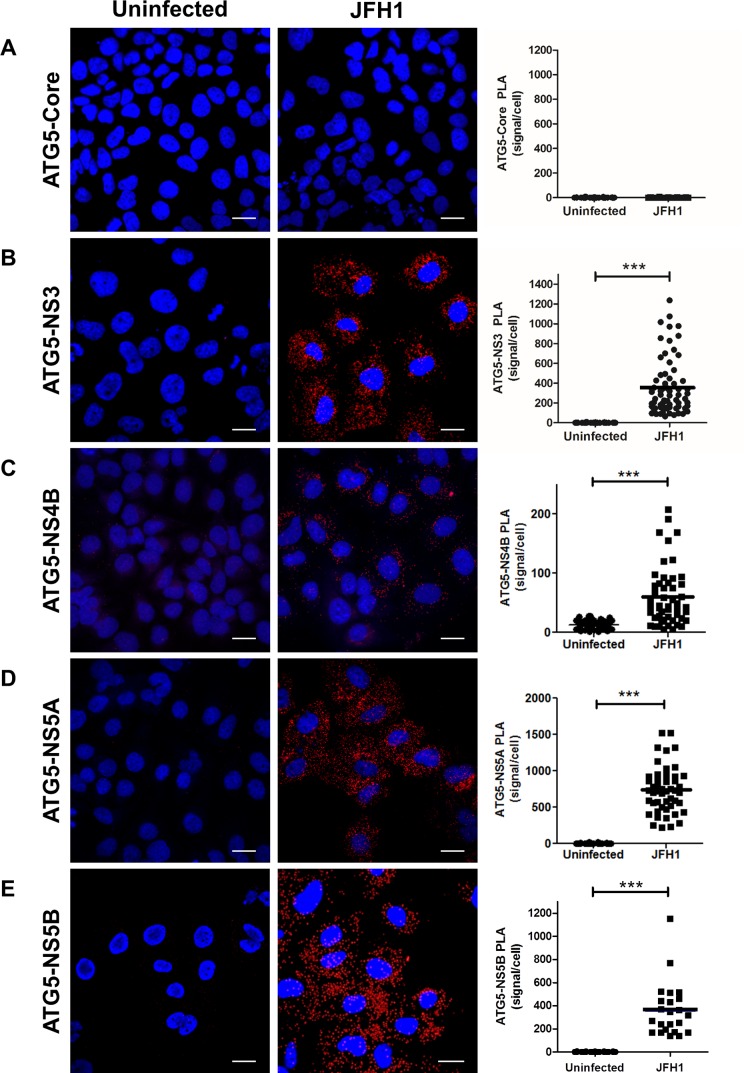
Assessment of ATG5-12 interactions with viral proteins in infected cells as observed by proximity-ligation assay (PLA).JFH1-infected at more than 90% or uninfected cells were fixed and processed for detection of ATG5-12-Core, ATG5-12-NS3, ATG5-12-NS4B, ATG5-12-NS5A or ATG5-12-NS5B complexes by PLA using appropriate antibodies. Nuclei were stained with DAPI (blue). Each PLA signal (red dot) indicates one interaction and were calculated as described in materials and methods section. In A, no significant difference in the frequency of PLA signals between JFH1-infected (n = 50) cells compared to uninfected controls (n = 50) indicating undetectable interaction between ATG5-12 conjugate and core. However, the incidence of PLA signals in B-E was significantly higher in JFH1-infected (n ≥23) cells compared to uninfected negative controls (N = 50) (P<0.0001, Student’s t-test) indicating complexes formation between ATG5-12 and NS3, NS4B, NS5A and NS5B. Scale bar, 20μm.